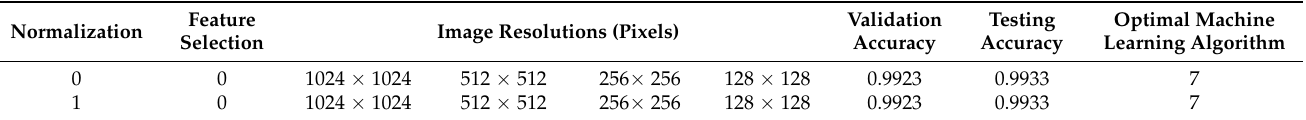
Table 4. Validation and testing three-category accuracies of the optimal CAD with texture analysis in the public dataset. Note: The optimal CAD was selected based on the validation accuracies of Table